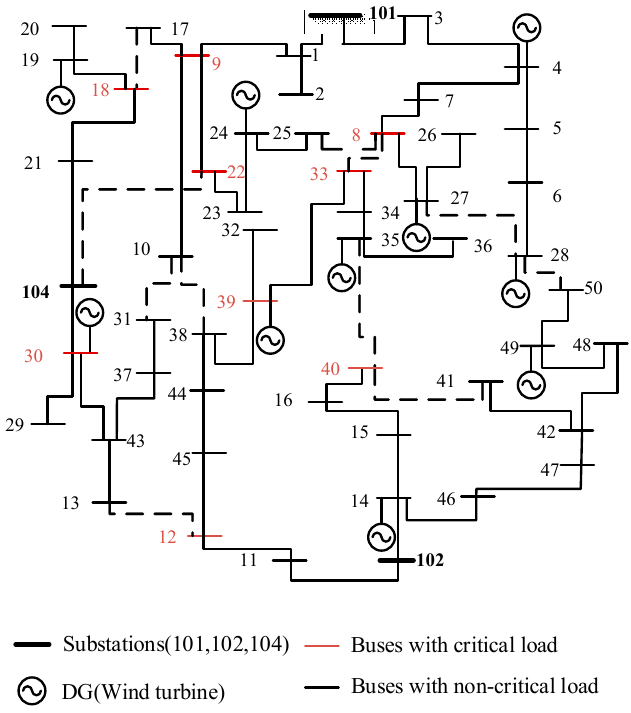
Figure 4. Topology and parameters of 53-bus power distribution network.